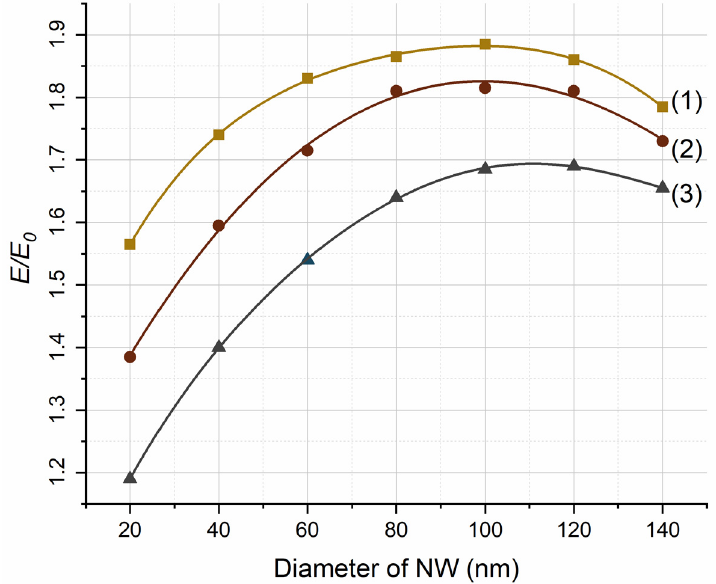
Figure 2. Simulated dependence of the normalized electric field amplitude (E/E 0 ) on the Ag-NW diameter at various distances from its surface: ( 1 ) 2.5 nm; ( 2 ) 5 nm; ( 3 ) 10 nm.